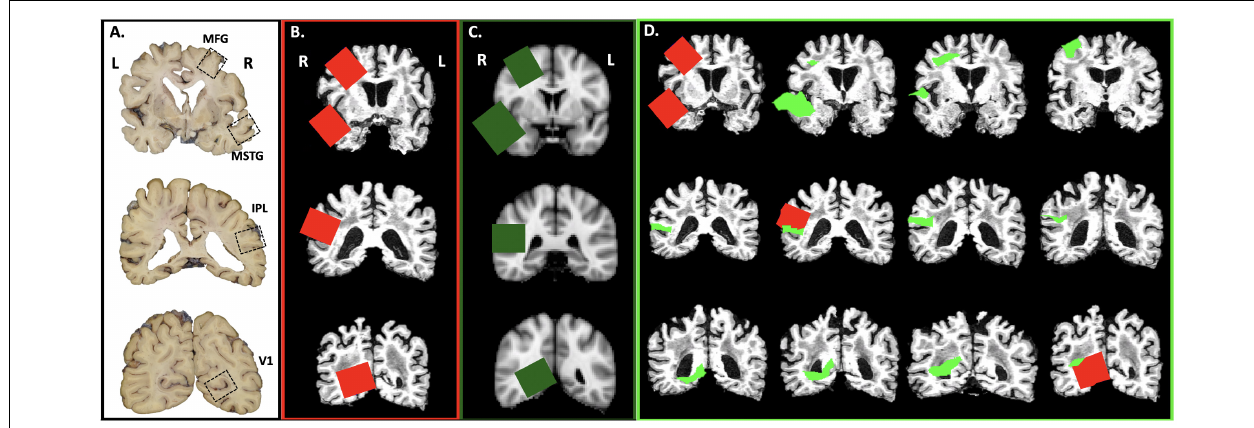
FIGURE 2 | Virtual Sampling protocol. (A) Here we show the cortical samples routinely taken at autopsy on coronal sections of fixed human brain that are oriented by anatomic convention (MFG, middle frontal gyrus; MSTG, middle and superior temporal gyri; IPL, inferior parietal lobule; V1, primary visual cortex. For traditional neuropathologic sampling, the neuropathologist targets the regions of interest (ROIs; open black boxes) using the gyral pattern and deep brain structures as landmarks on the sliced human brain. (B) To mimic traditional neuropathologic sampling in silico , we generated coronal slices using each subject’s native space T1-weighted MRI. An example subject is shown in radiological convention. The neuropathologist identified the ROIs on the MRI slices ( subject-specific samples; red) using the same gyral patterns and deep brain structures as would be used in physical brain slices. (C) The MNI space template brain was then used to create similar coronal slices and ROIs were identified as before ( target samples, green boxes). (D) Finally, the ROIs identified on the coronal sections of the MNI space template brain were aligned to each subject’s T1-weighted MRI ( reference samples, light green). A series of adjacent 4 mm thick coronal sections from a single subject’s native space T1-weighted MRI illustrates the variability between the subject-specific and reference samples.